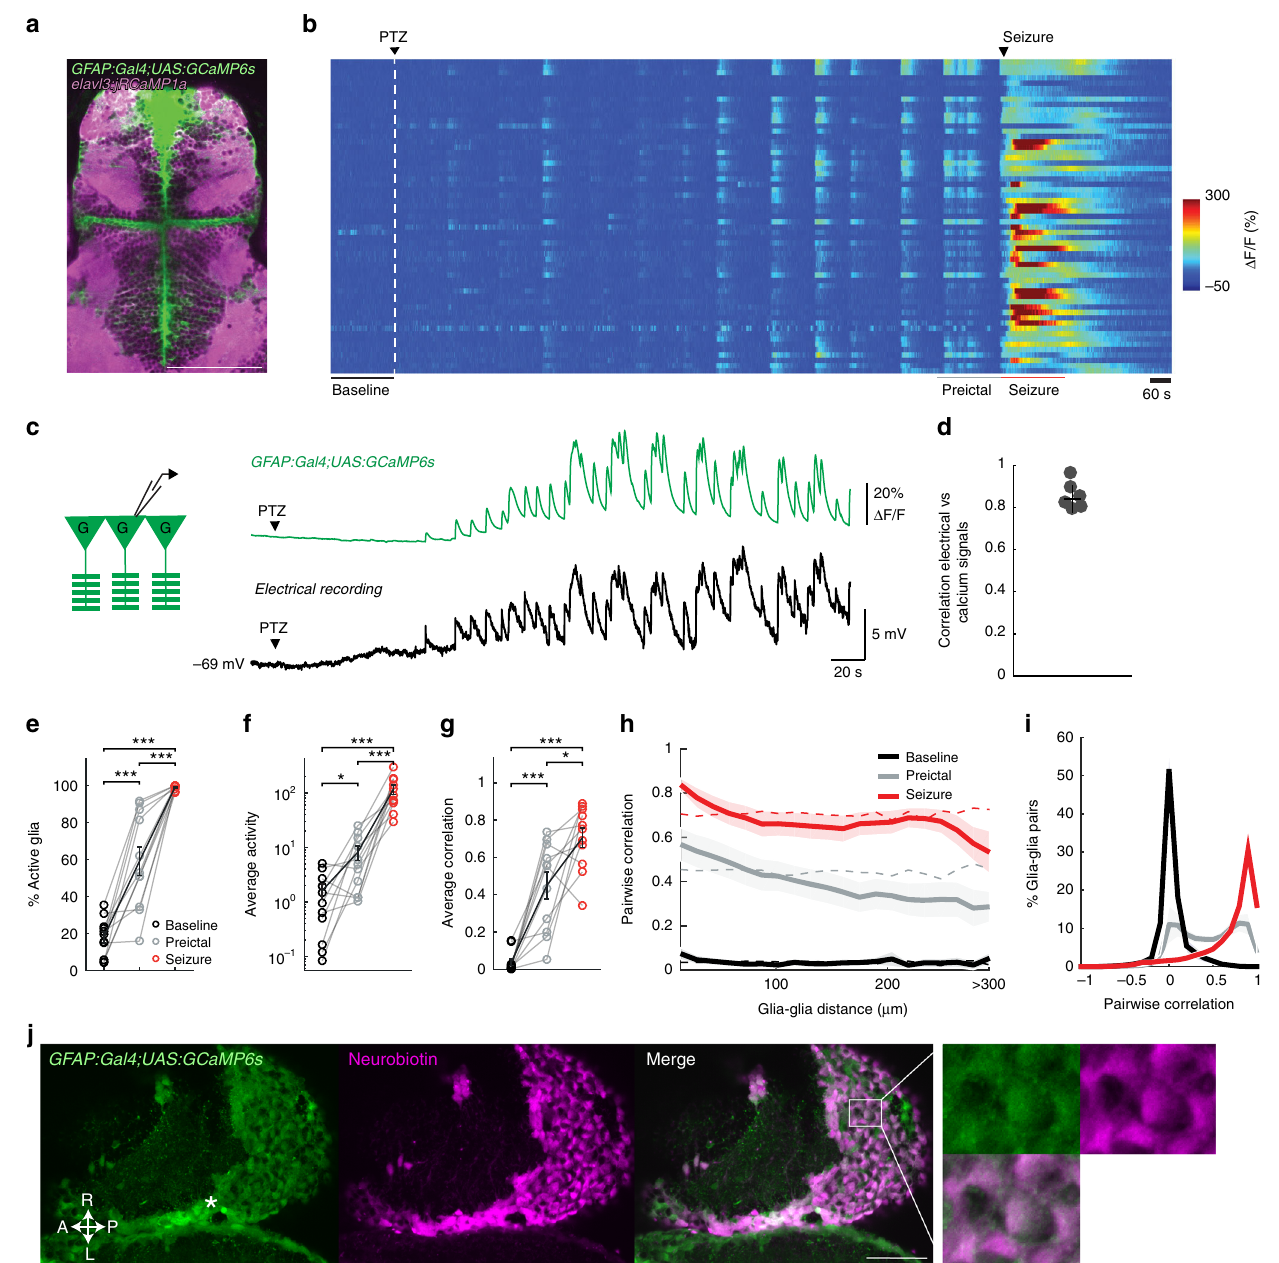
Fig. 4 Glial cells are highly active and strongly synchronized already during preictal period. a Confocal image of a transgenic zebra fi sh larvae expressing GCaMP6s in GFAP positive glial cells (green) and jRCaMP1a in elavl3 positive neurons (magenta), dorsal view. b Glial calcium signals measured by two- photon microscopy in Tg(GFAP:Gal4)nw7;Tg(UAS:GCaMP6s) transgenic zebra fi sh larva. White dashed line indicates the start of 20 mM pentylenetetrazole (PTZ) perfusion. c Simultaneous patch-clamp recording of glial membrane potential and epi fl uorescence calcium recordings of Tg(GFAP:Gal4)nw7;Tg(UAS: GCaMP6s) transgenic zebra fi sh, during PTZ-induced epileptic activity. d Correlation of electrical activity and calcium signals from individual glial cells, n = 6 cells/zebra fi sh. e Percentage of active glial cells (>3std baseline ) during baseline (black), preictal (gray), and seizure (red) periods. f Average activity of the active glial cells, de fi ned by the area under the curve of the Δ F/F trace. g Average pairwise Pearson ’ s correlation between glial cells. h Relation between pairwise correlation of glial activity and the distance between each glial pair. Dotted lines represent the results when glial locations are shuf fl ed. i Histogram representing the distribution of the correlation coef fi cients between glial cells during baseline (black), preictal (gray) and seizure periods (red). j Confocal image showing GFAP positive radial glia expressing GCaMP6s (green) and neurobiotin coupling between glial cells (magenta) after fi lling a single glia with neurobiotin by patch-clamp electrode. Location of the patch-clamped glial cell is indicated with *. A, anterior; P, posterior; L, left; R, right. White bars re fl ect 100 µ m ( a , j ). * ** p = < 0.001, * p = < 0.05, ns = not signi fi cant, Wilcoxon signed-rank test. Error bars and shaded regions represent the s.d. of n = 6 cells ( d ) or s.e.m. of n = 11 fi sh ( e – i